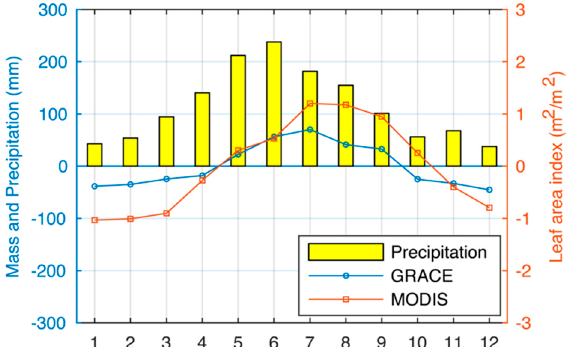
Figure 5. Monthly change of LAI, mass, and rainfall in our study region calculated using mean values of the same month. The blue line is the mass change measured by GRACE, the red line is the LAI measured by MODIS, and the yellow bar is the rainfall from Global Precipitation Climatology Project (GPCP).